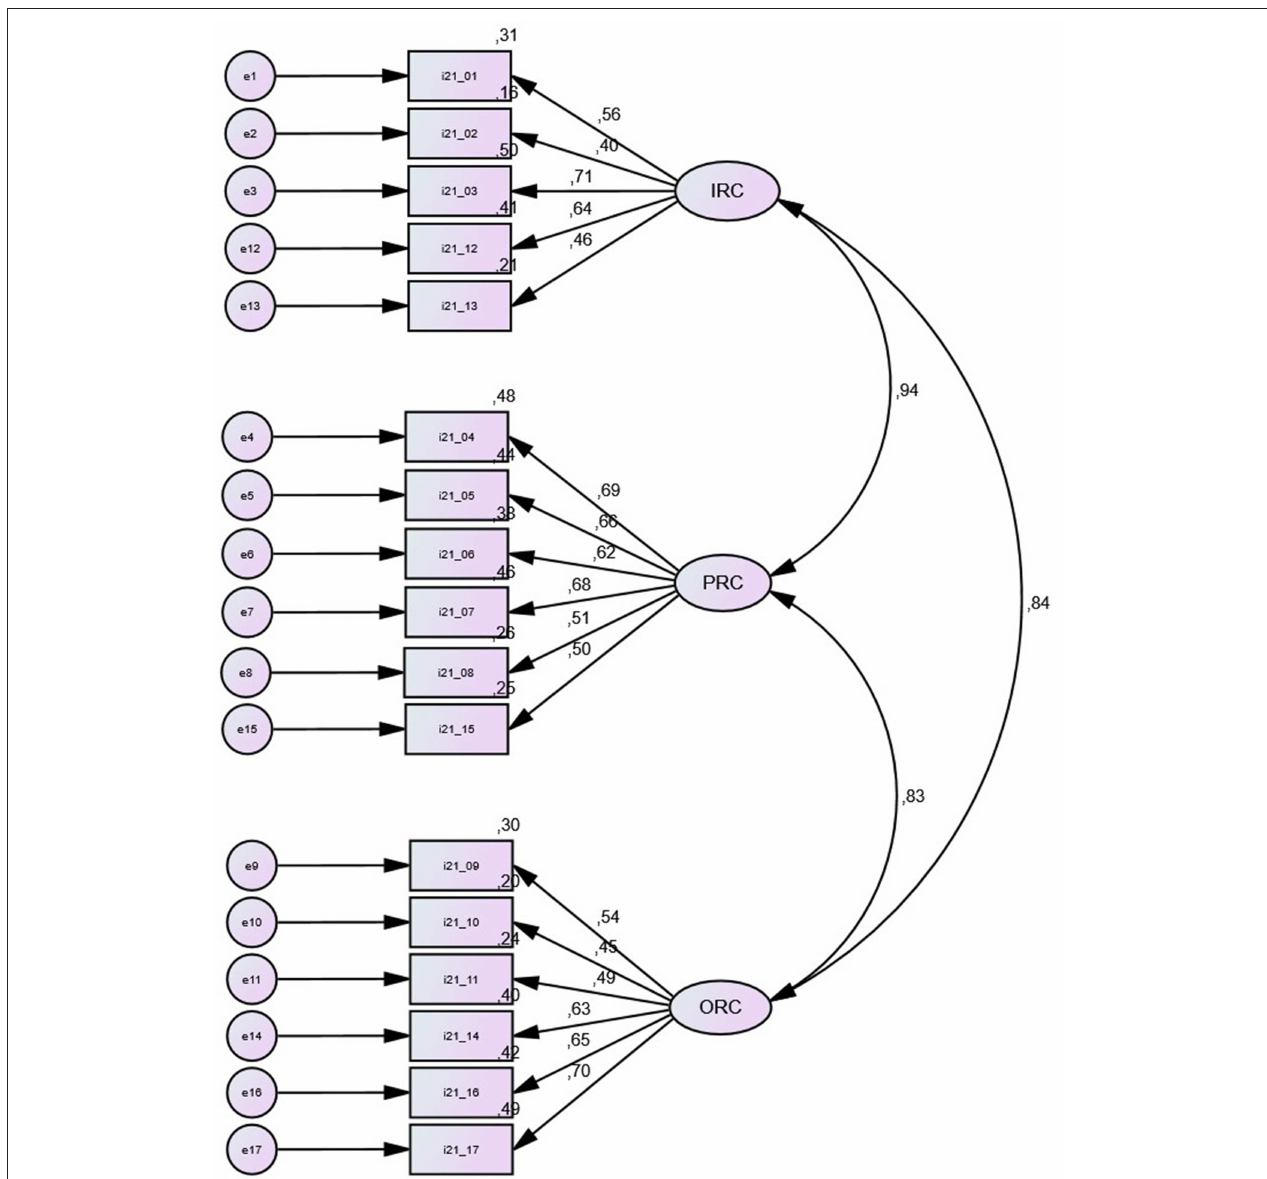
FIGURE 1 | Initial hypothesized measurement